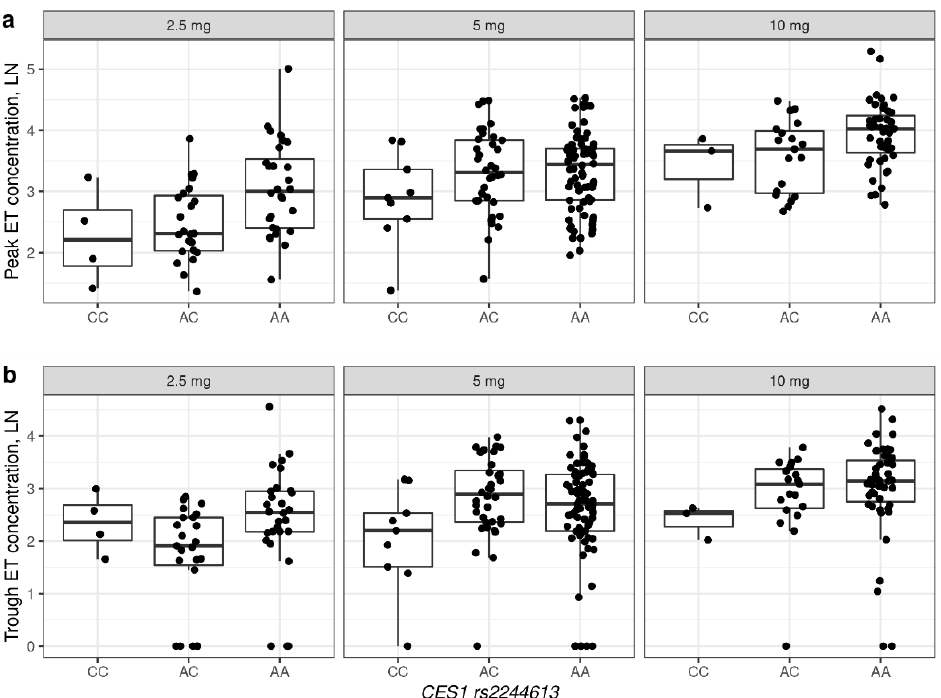
Figure 1. Peak ( a ) and trough ( b ) concentrations of enalaprilat, based on CES1 rs2244613 genotypes in patients receiving different doses of enalapril. The figure shows concentrations for which there was more than one observation for each genotype. ET — enalaprilat. Ln — natural logarithm.